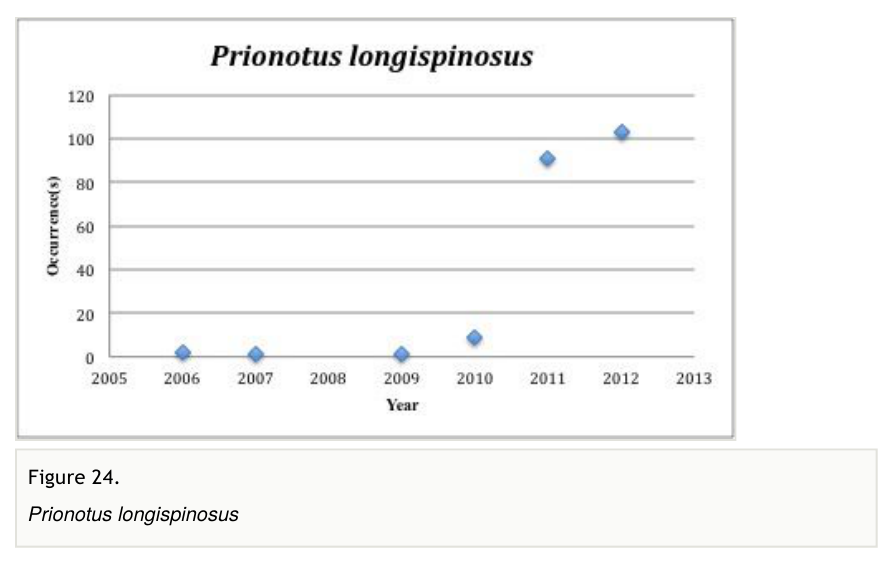
Figure 24. Prionotus longispinosus